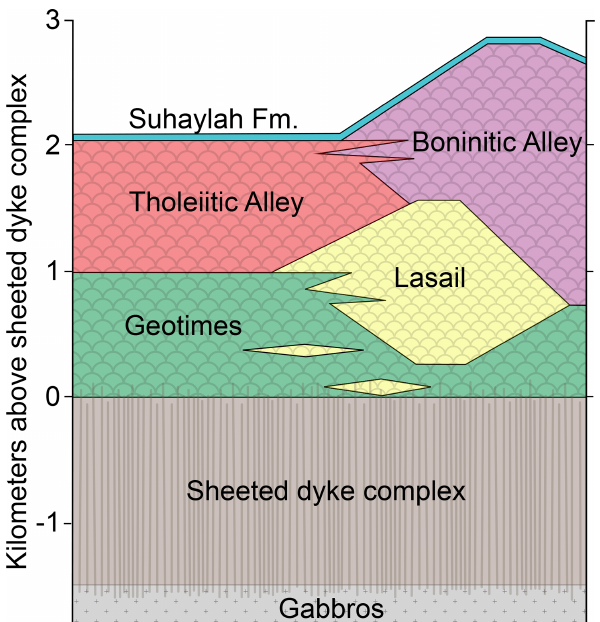
Figure 2. Semail ophiolite volcanostratigraphy with capping pelagic sediments (Suhaylah Formation) and sheeted dyke complex (SDC), with approximate stratigraphic thicknesses revised accord- ing to field observations in this study after Alabaster et al. (1982), Gilgen et al. (2014), and Belgrano and Diamond